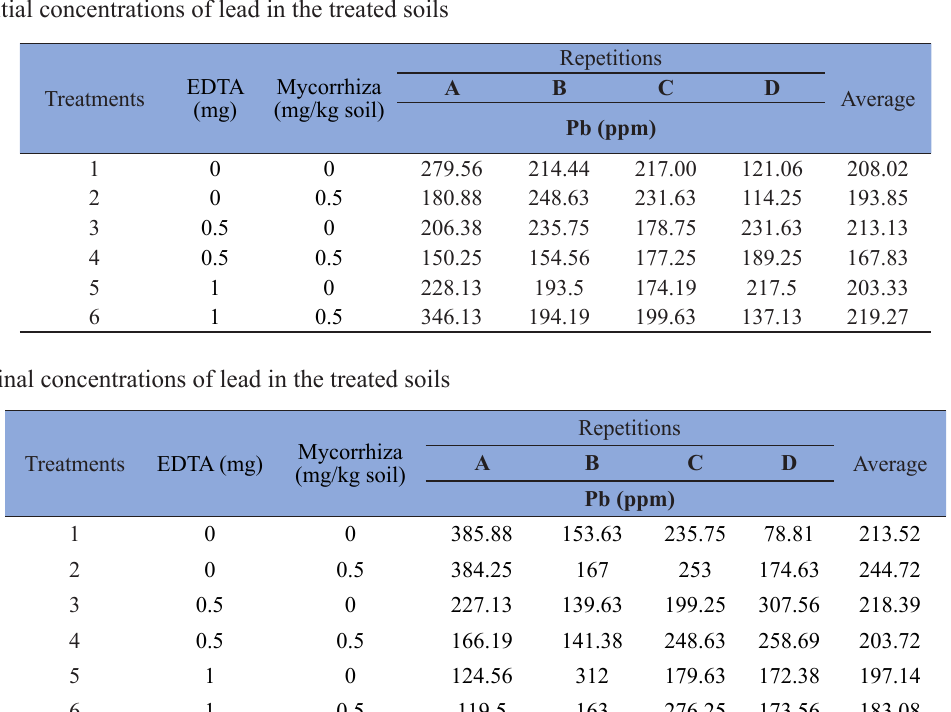
Table 5 : Initial concentrations of lead in the treated soils